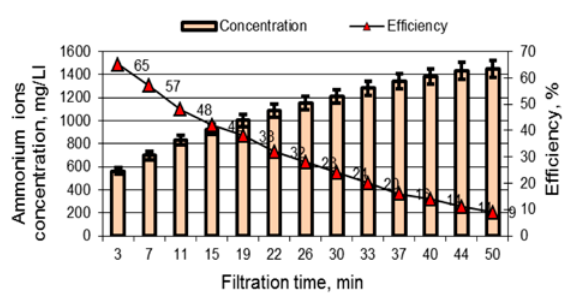
Table 6. Experimental results of sedimentation process, initial NH 4+ concentration in the sludge liquid was 1450 mg/L, TSS –1090 mg/L